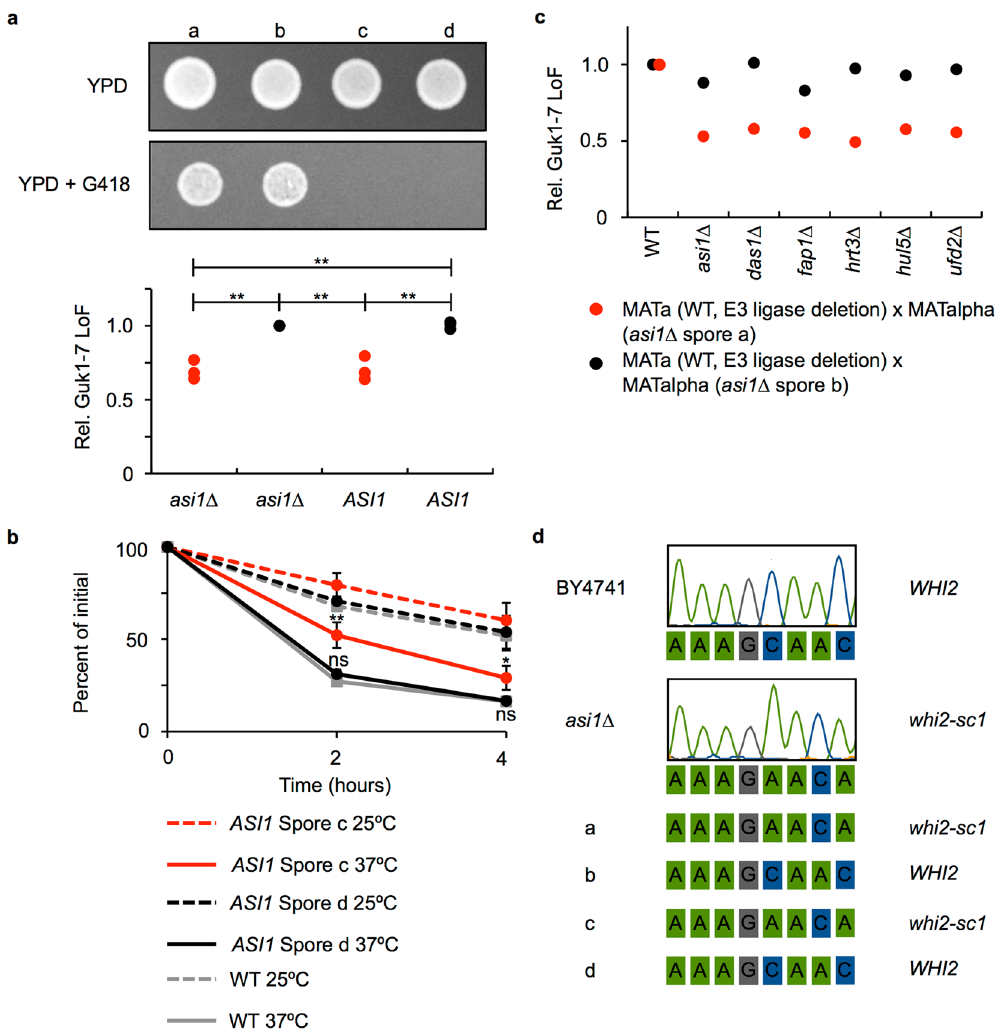
Figure 2. Mutations in WHI2 segregate with the Guk1-7-GFP stability phenotype. ( a ) Analysis of a representative tetrad derived from the mating of MAT a asi1 ∆ and MAT alpha BY4742 cells. Growth was assessed on the indicated plates (top) and the relative loss of fluorescence (Rel. LoF) of Guk1-7-GFP was determined following incubation with CHX at 25°C or 37°C for 2 hours (bottom). Results represent three independent experiments and p values were calculated with a one-way ANOVA and post-hoc Tukey HSD to assess significance, ** denotes p < 0.01. ( b ) Spores c and d, produced from the asi1 ∆ backcross shown in ( a ), expressing Guk1-7-GFP were incubated with CHX at 25°C or 37°C for four hours. Samples were analysed by flow cytometry at the indicated time points. The results represent the mean and standard deviation of three independent experiments. P values were calculated with a two-tailed unpaired Student’s t -test ( * , ** , and ns denote p < 0.05, 0.01, and not significant, respectively). ( c ) Complementation test in which the indicated diploids expressing Guk1-7-GFP were incubated with CHX for two hours at 25°C or 37°C and analysed by flow cytometry. MAT a E3 ligase deletion strains or WT BY4741 were mated with MAT alpha asi1 ∆ cells from spore a (red) and b (black). ( d ) Whole genome sequencing of BY4741, asi1 ∆ , and the four asi1 ∆ backcross spores (shown in a ) revealed a single base pair deletion in the coding sequence of WHI2 that co-segregates with the Guk1-7-GFP stability